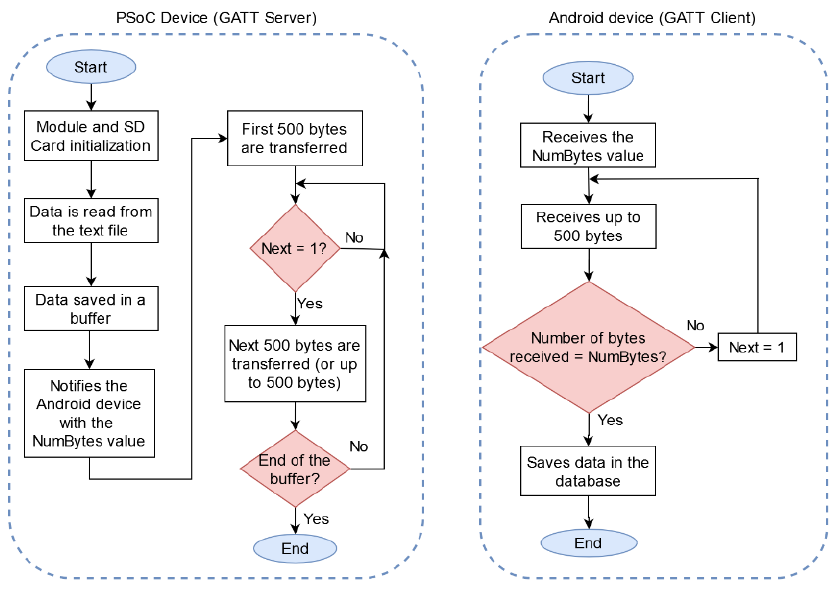
Figure 6. Developed algorithm for data transfer using a BLE connection.